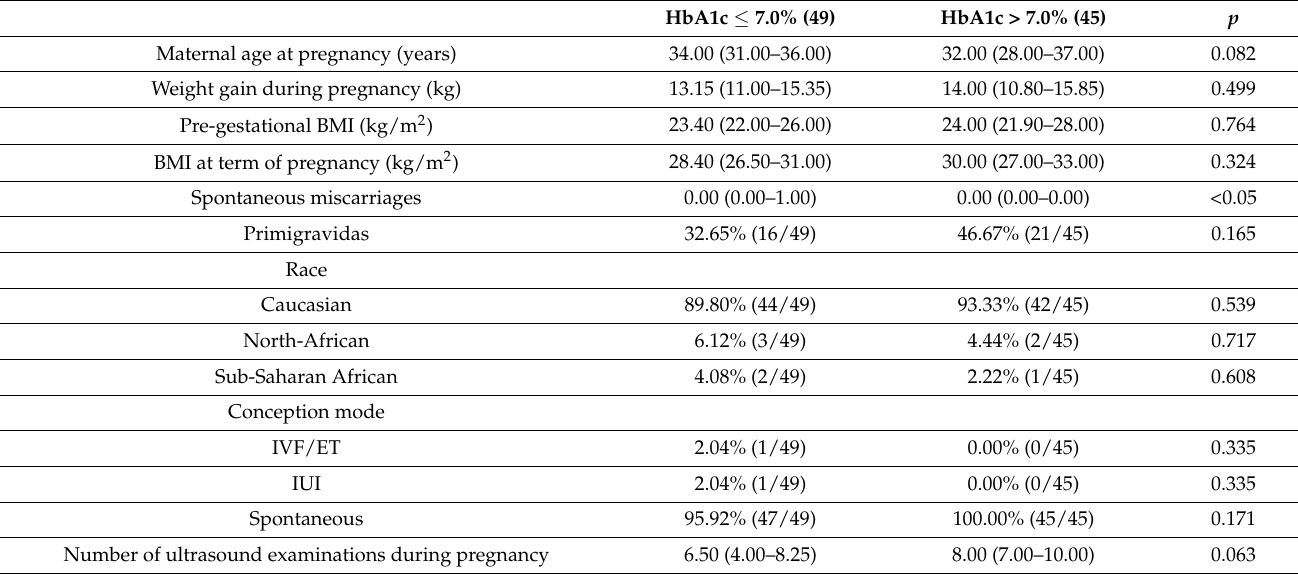
Table 1. Baseline features of patients affected by pregestational diabetes who delivered at University Hospital of Udine between 1998 and 2017 and subdivided in two groups: 49 with HbA1c higher than 7% and 45 with HbA1c lower than 7%.